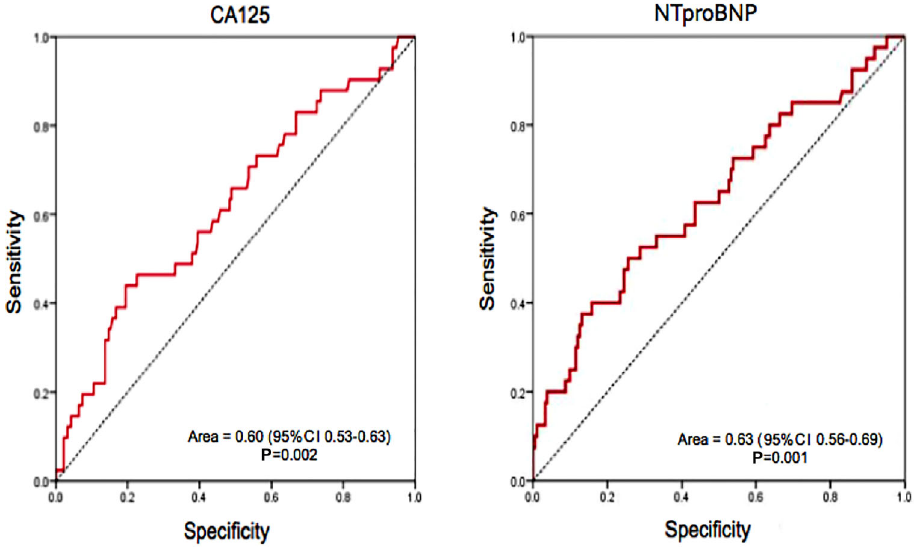
Figure 1. Receiver operating characteristic analysis of carbohydrate antigen 125 (CA125) and N-terminal pro brain natriuretic peptide (NTproBNP) for identifying pulmonary congestion.